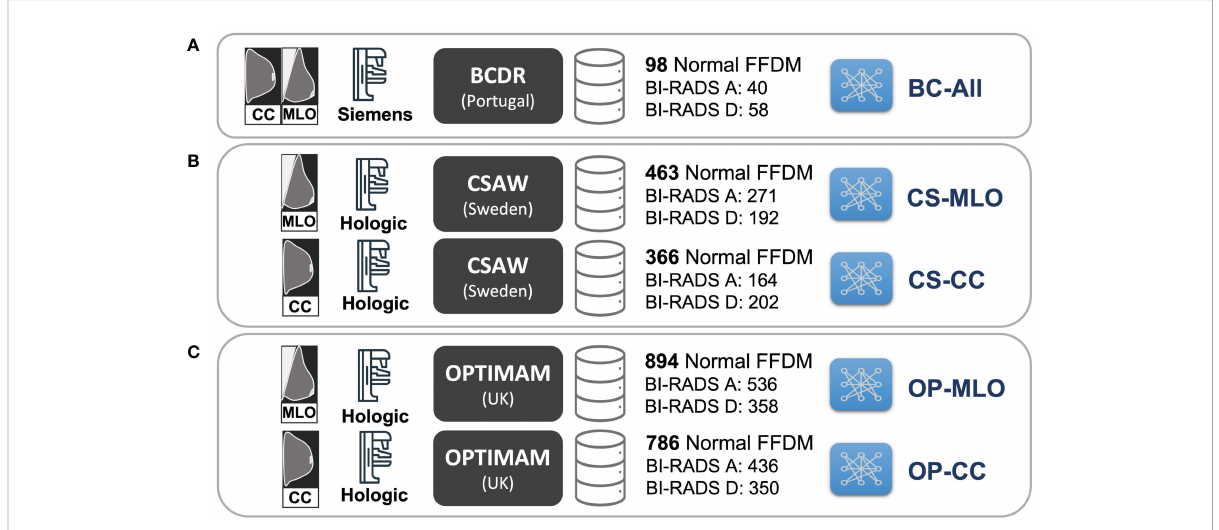
FIGURE 3 Training setup for the different CycleGAN models. (A) BC-All model for both CC and MLO views trained with 98 normal FFDMs from BCDR dataset. (B) two models for CC ( CS-CC ) and MLO ( CS-MLO ) views trained with 463 and 366 normal FFDMs from CSAW dataset. (C) two models for CC ( OP-CC ) and MLO ( OP-MLO ) views trained with 894 and 786 normal FFDMs from OPTIMAM Hologic